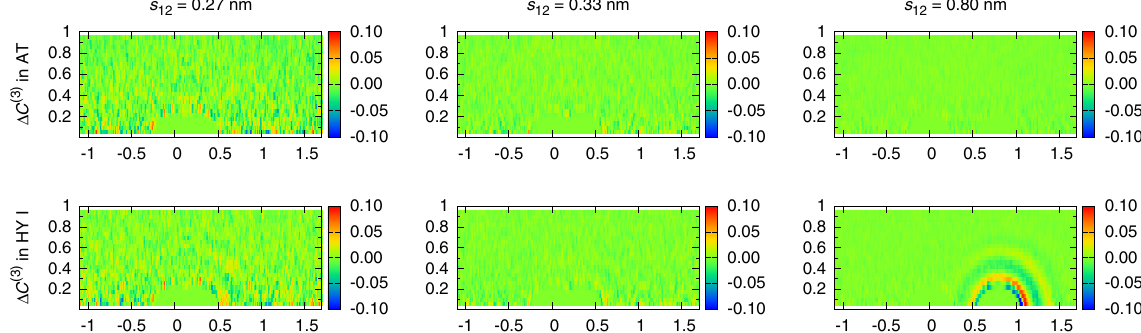
FIG. 7. The three-body correlation of the WCA AdResS in the AT and HY I regions. The difference with respect to the full atomistic reference (see the first line of Fig. 4) is plotted in this figure. From left to right, the distances between the first two molecules are s 12 ¼ 0 : 27 , 0.33, and 0.80 nm,